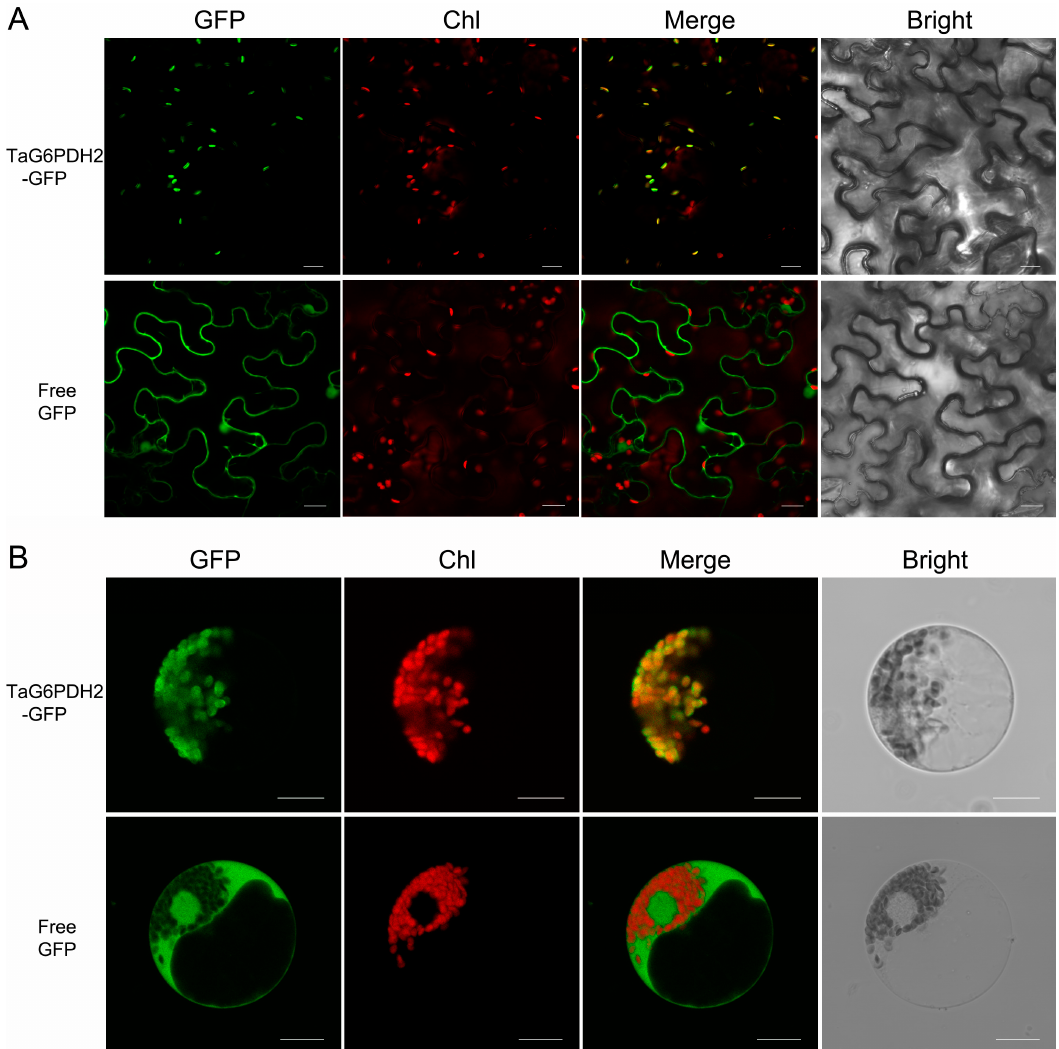
Figure 1. Subcellular localization of TaG6PDH2 in plants. ( A ) Transient expression of free GFP or TaG6PDH2-GFP fusion protein in N. benthamianain leaves. ( B ) Free GFP or TaG6PDH2-GFP fusion proteins were expressed in wheat protoplasts. All signals were detected by an Olympus FV3000 confocal microscope. Scale bars, 20 μ m. Chl, chlorophyll. GFP fluorescence is shown in green. Red fluorescence represents chlorophyll auto-fluorescence. Bright-field images indicate that the identical field was observed under white light. Merged GFP and chlorophyll images are presented.